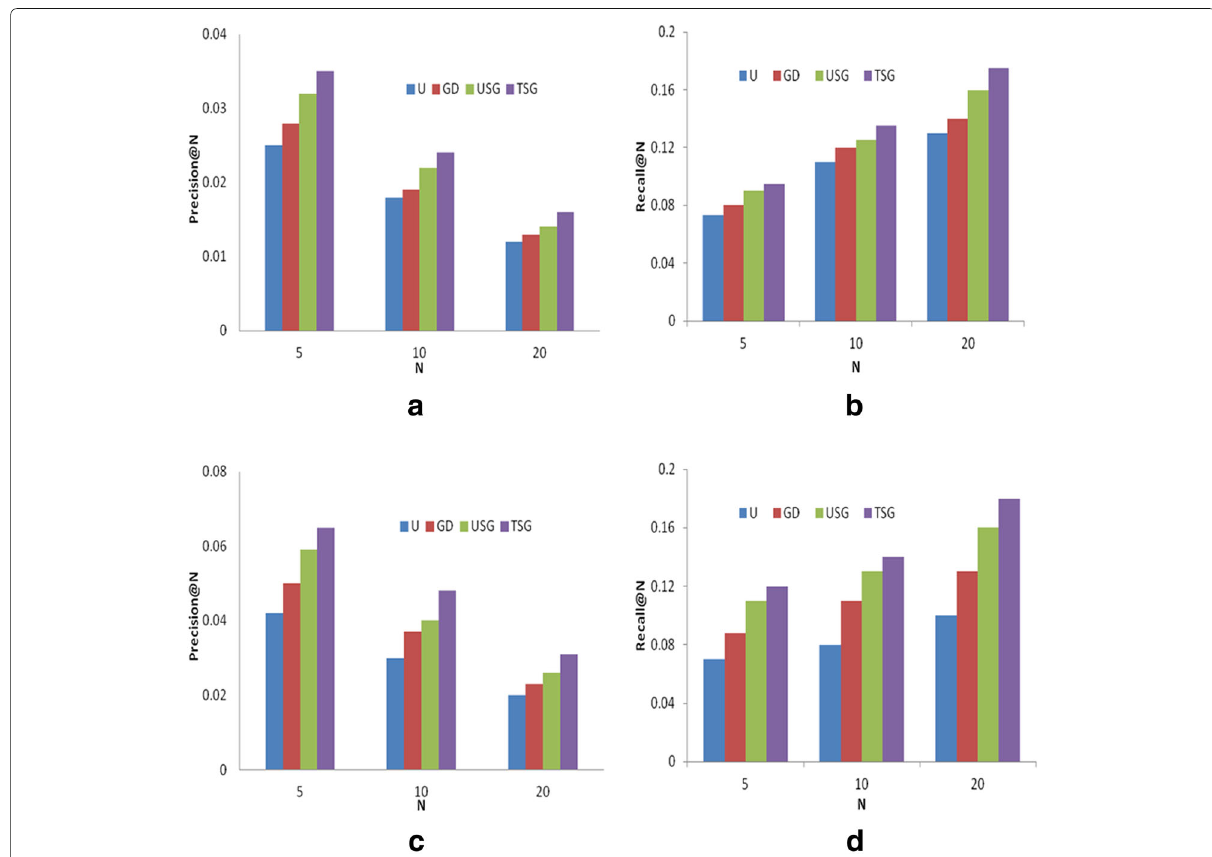
Fig. 6 POI Recommendation Performance comparison. a Precision@N-Foursquare. b Recall@N-Foursquare. c Precision@N-Gowalla. d Recall@N-Gowalla